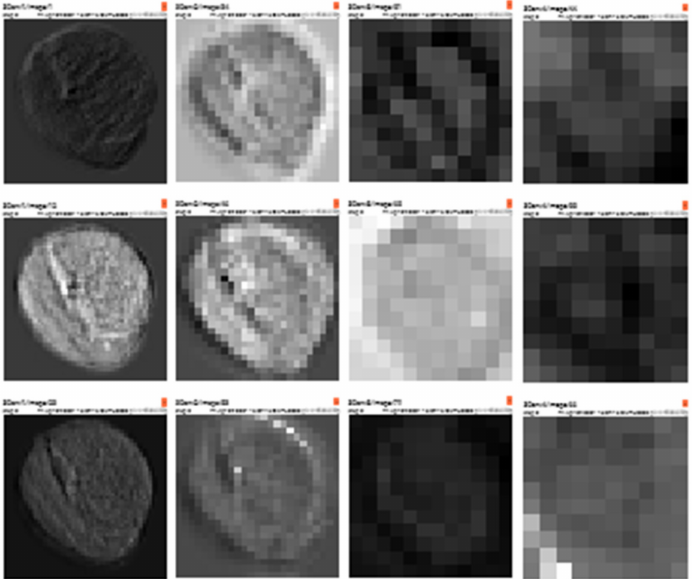
Figure 14. Convolution visualization results of the new network-final model (the columns of images from left to right represent the results obtained for Convolutional Layers